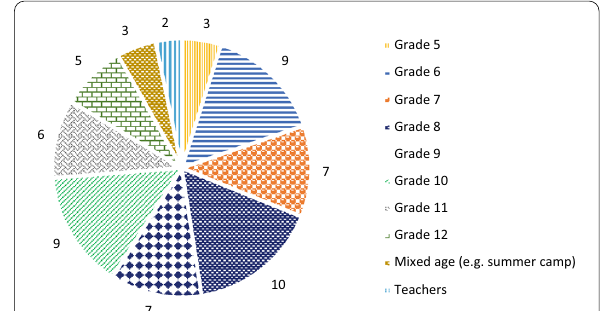
Fig. 6 Cohort described in the reviewed studies